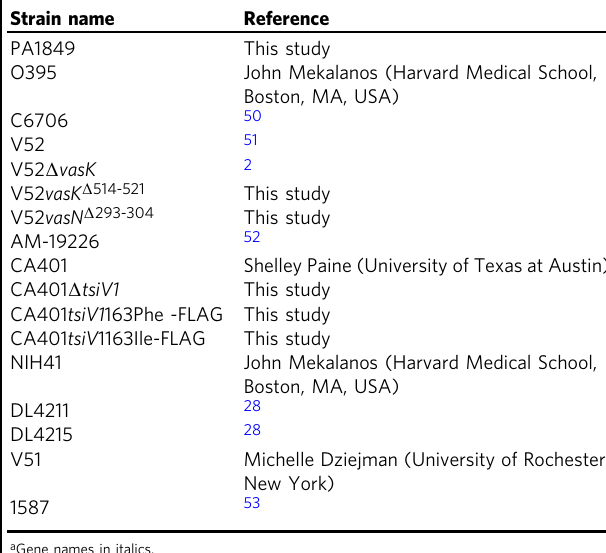
Table 1 List of Vibrio cholerae strains used in this study and their reference/source a